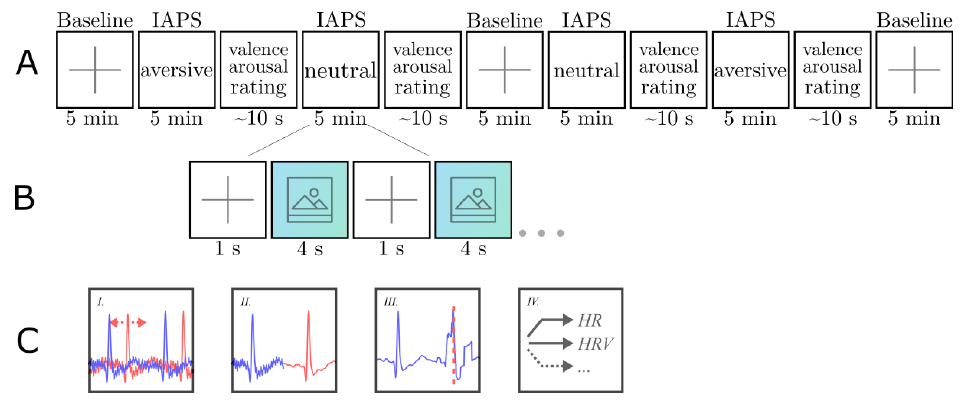
Figure 2. Block diagram of the experimental protocol and analyses pipeline, depicting the stimuli blocks ( A ), the fixation cross and picture presentation ( B ), and the overall processing pipeline ( C